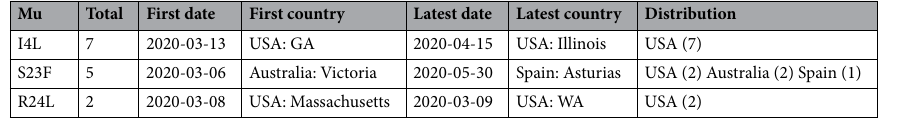
tion. Alignment of these sequences is shown in Fig. 9. The number of nonsynonymous mutations in gene S is 3711, with 240 distinct mutations. Mutations that occur in 10 or more cases are reported in Table 10. The number of synonymous mutations is 670, making a